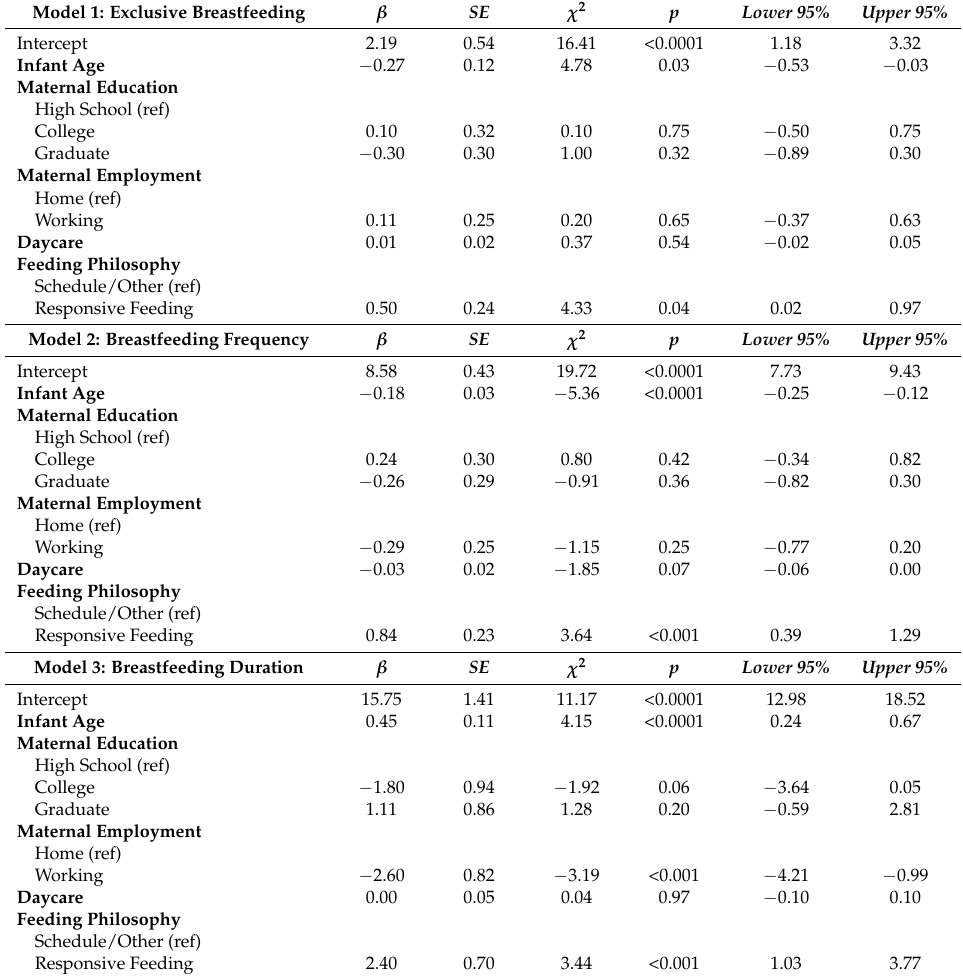
Table 4. Results of the logistic regression predicting exclusive breastfeeding (feeding only breastmilk to infants under six months) from self-reported responsive feeding (Model 1), results of the linear regression predicting feeding frequency (average number of breastfeeding sessions per day) from self-reported responsive feeding (Model 2), and results of the linear regression predicting planned breastfeeding duration (in months) from self-reported responsive feeding (Model 3) in Study 1. Model 1: Exclusive Breastfeeding